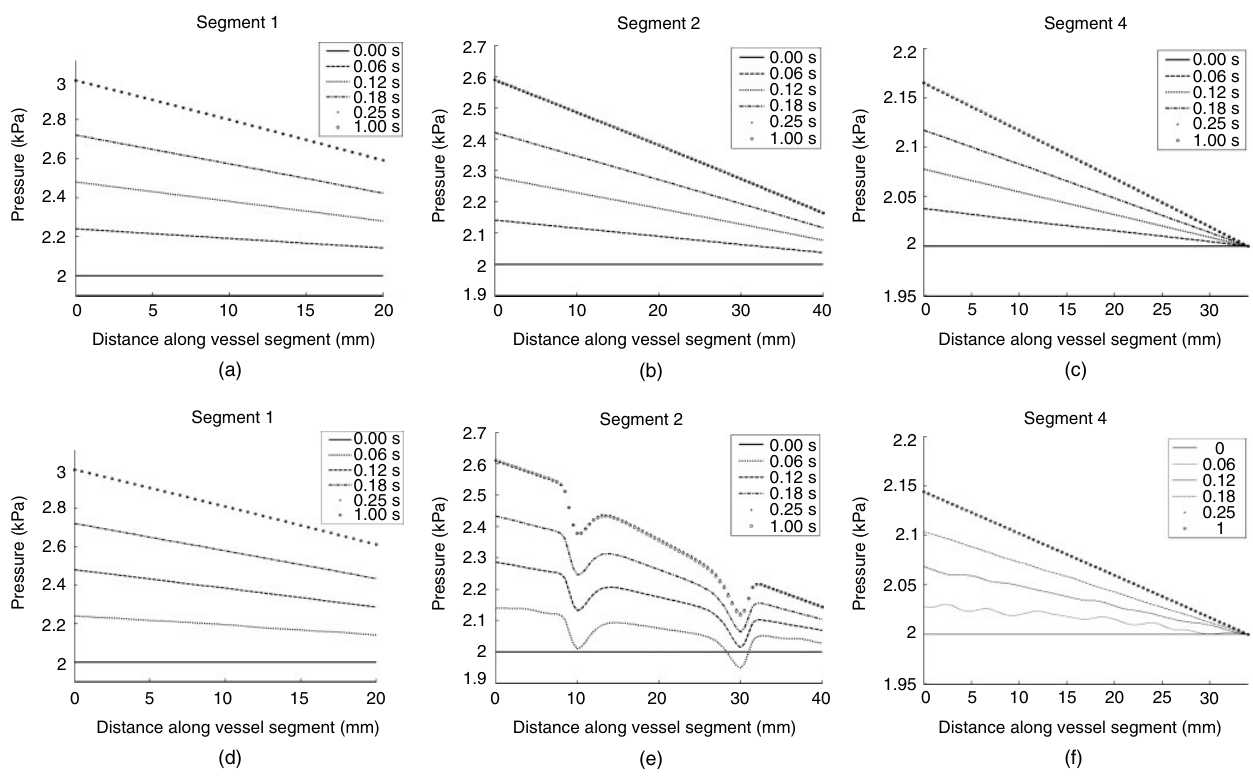
Figure 4 Pressure along different vessel segments at the times shown in the legends of the plots in the unstented ((a)–(c)) and stented ((d)–(f)) cases. The results for 0.25 s and 1.0 s are very similar to each other and appear together as the top line in all the plots. See Figure 1 for the positions of the vessel segments in the